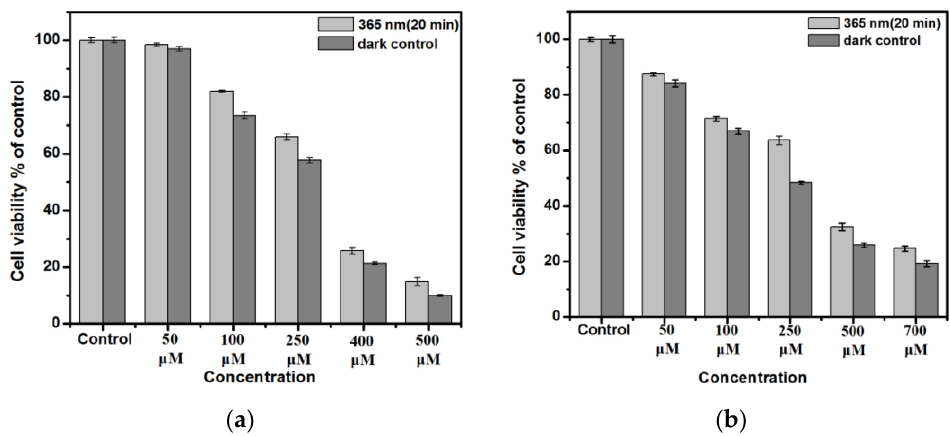
Figure 3. Cell viability of RAW264.7 cell ( a ) and HT29 ( b ) in presence of 4 . Cells were grown in the presence of 4 (50–500 μ M) and right in the dark or irradiated at 365 nm for 20